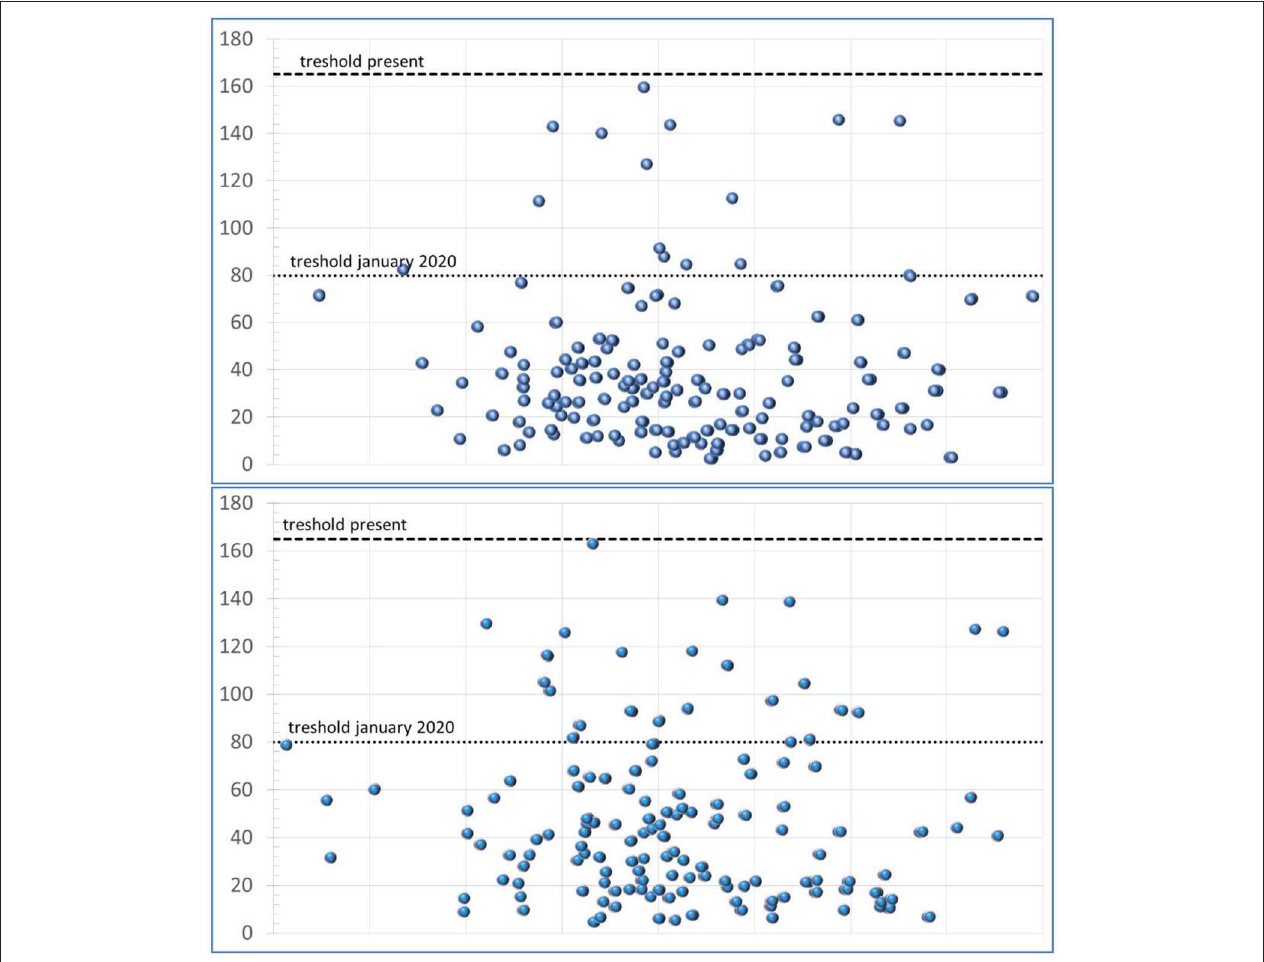
FIGURE 1 | Real-world driving emissions of NOx of diesel vehicles. NOx total (mg/km) vs. PM total (#/km). Top total RDE. Bottom urban RDE. Data digitized from